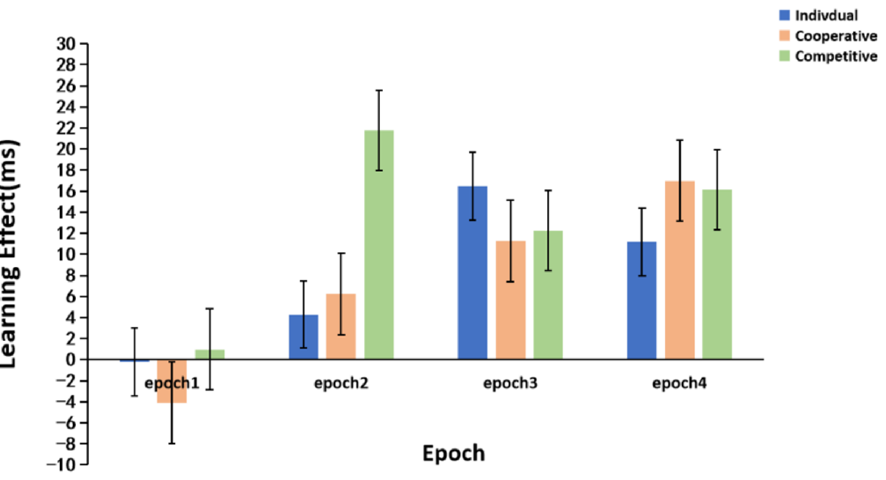
Figure 6. Statistical learning effects for the individual group, cooperative group, and competitive group. The error bars indicate the standard error.